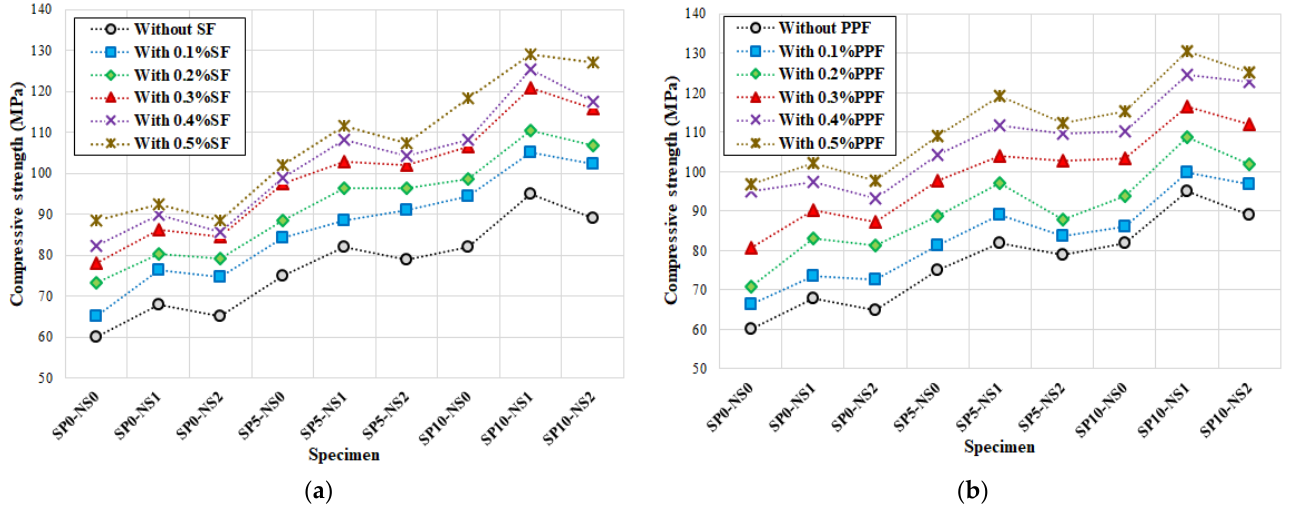
Figure 8. Influence of fibres on the compressive strength of HSC ( a ) SF and ( b ) PPF. On the other hand, raising the amount of SP led to enhancing the compressive